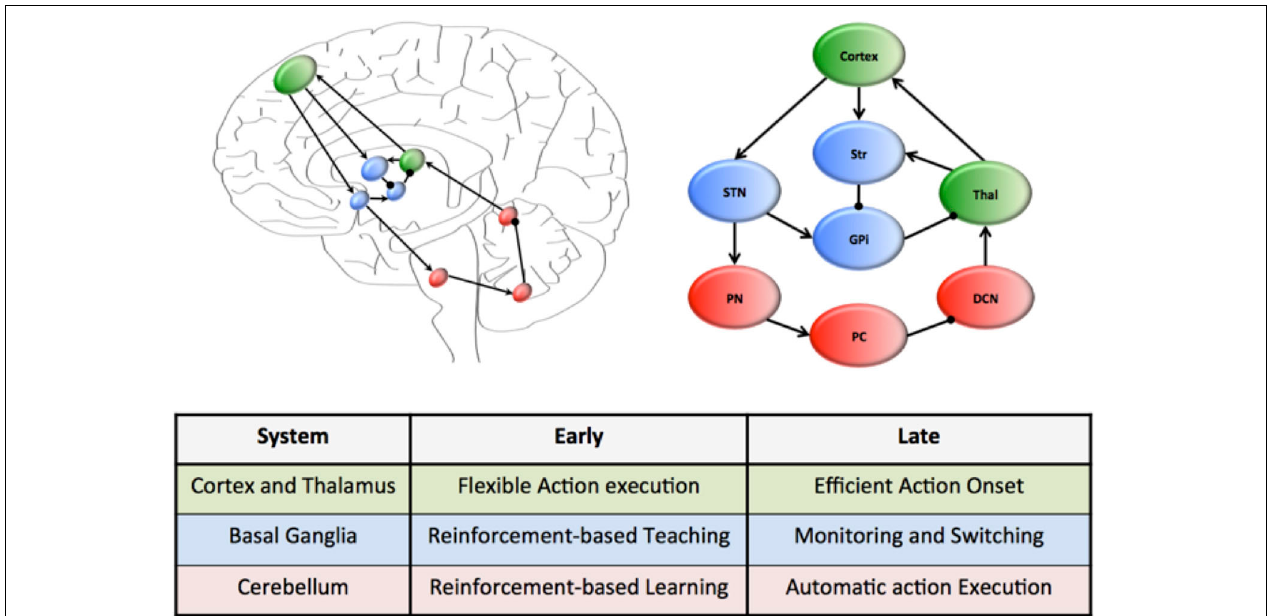
FIGURE 1 | Hierarchical neural circuits that control learning in the human brain. The cortex (green) is preferentially involved early in the course of learning, allowing flexible responses to rapidly changing environmental contingencies. Through extensive connections with the basal ganglia nuclei (blue), which are under the regular influence of neuromodulatory signals reflecting prediction error and salience, the cortex is able to transfer the performance of complex tasks to rigid yet reproducible neuronal motifs